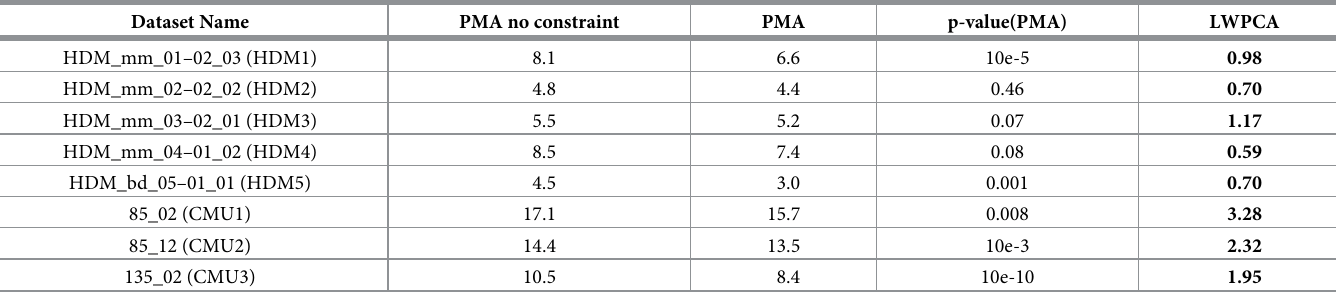
Table 3. Mean recovery errors comparison with Table 2 of [18].